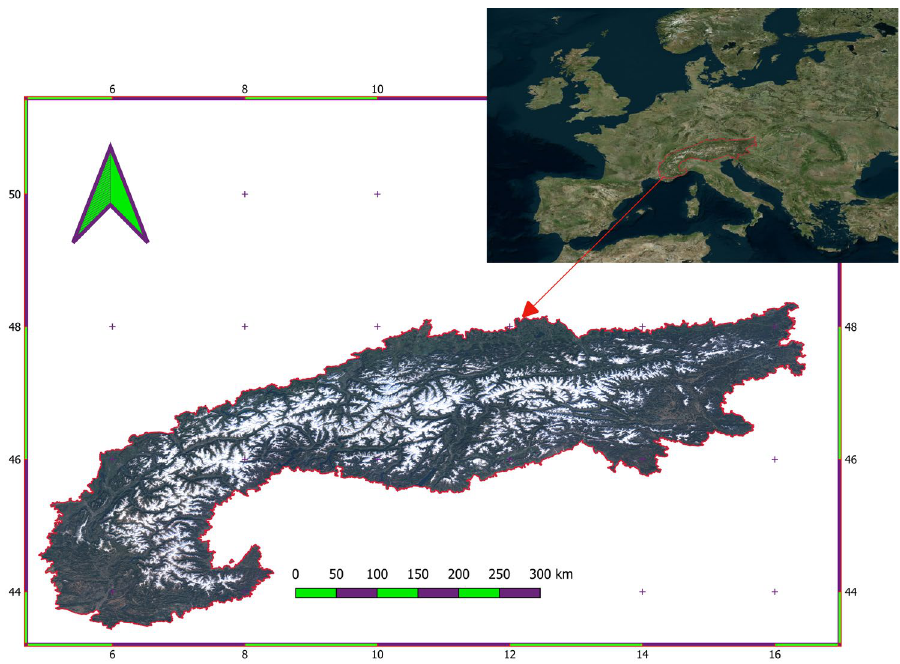
Figure 1. Alpine chain considered as development area for the GEE PMs algorithm. EPSG: 4326.